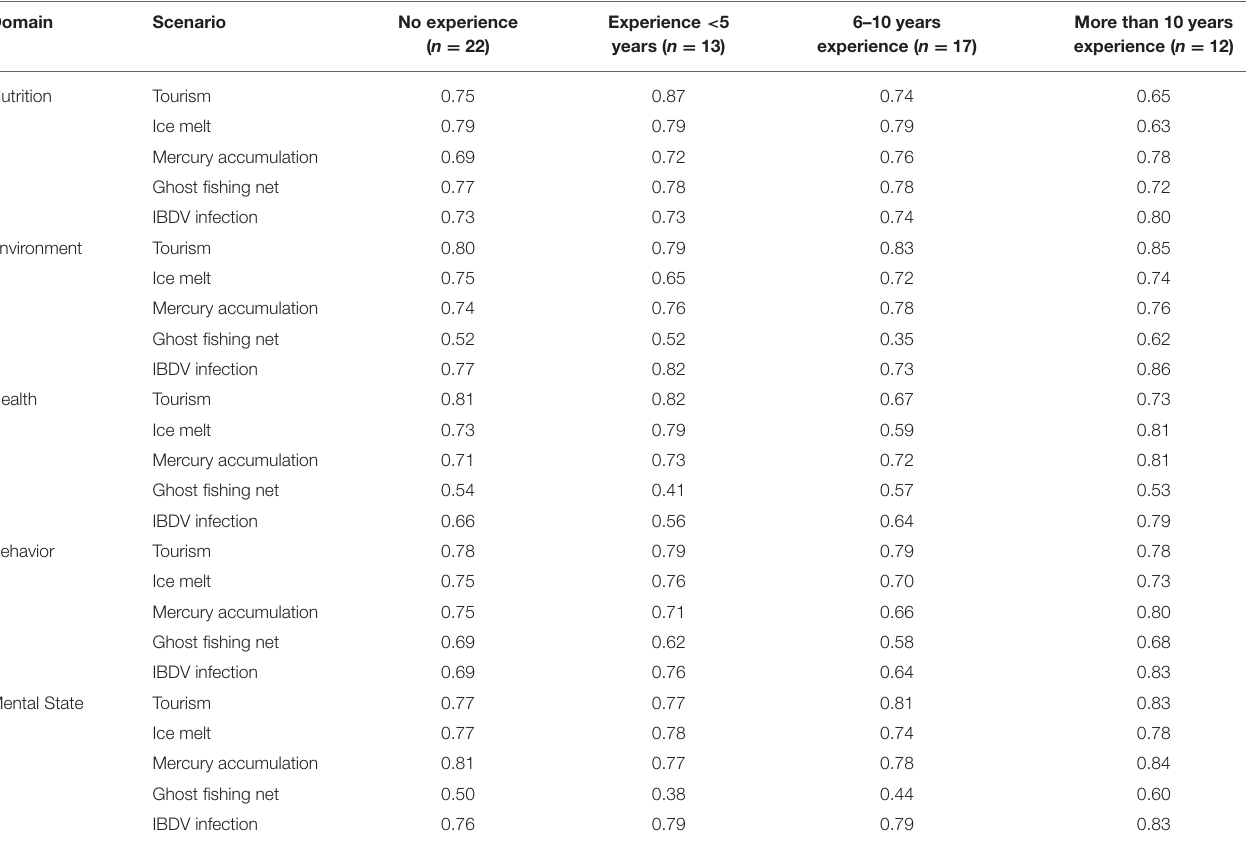
TABLE 3 | Unlike scores based on the 5-point-scale for each domain and scenario for participants without experience of penguins ( n = 22) and participants with prior experience of working with penguins.